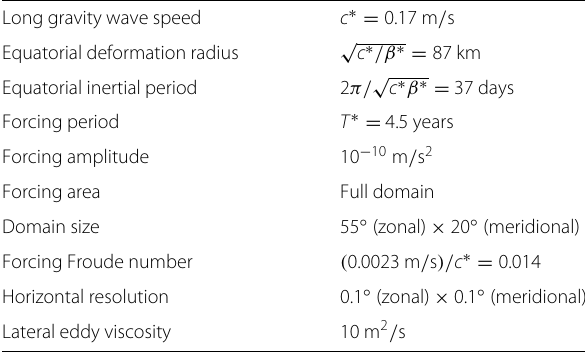
Table 4 Parameters in the model experiment of the present